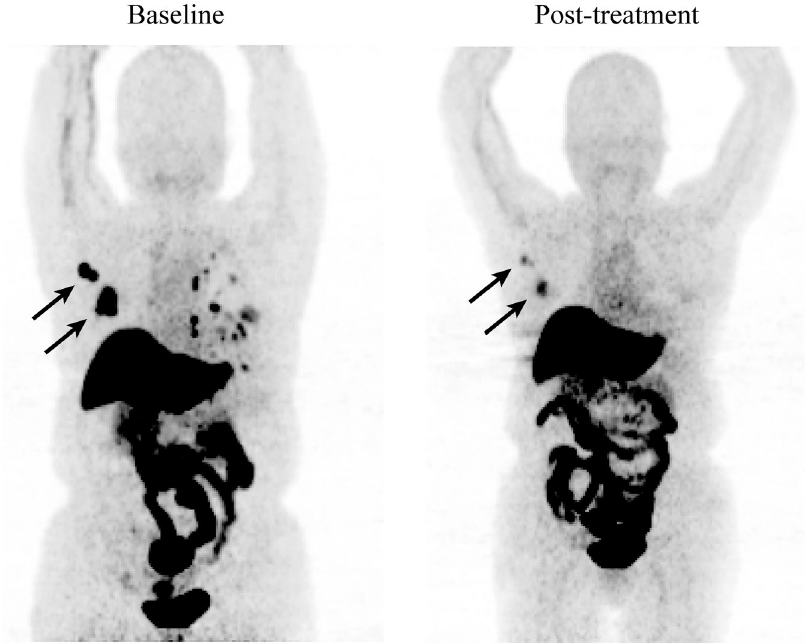
Figure 7. A 68-year-old female breast cancer patient, pretreatment with 18 F-FES PET/CT (A) showed high uptake in these metastatic lesions (SUVmax = 4.8–20.15). After two cycles of combination treatment (group TF), these lesions had obvious decreases in 18 F-FES uptake (SUVmax = 2.31–7.26, B). The greatest change was observed in the right axillary lymph node ( > 70%, arrow). The patient had a PFS > 12